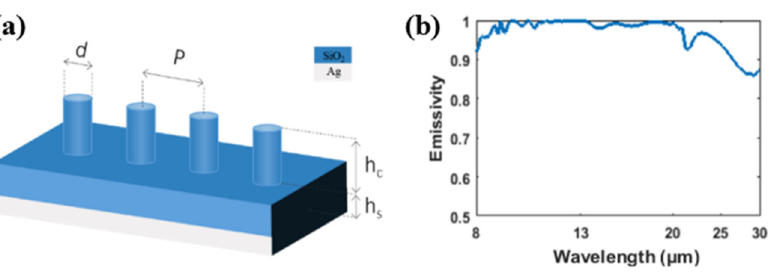
Figure 10. ( a ) Improved structure: patch-antenna-like cylinder array. The period ( P ) of the cylinder is 12 µ m. The diameter ( d ) of the cylinder is 4 µ m. The thickness of the silica layer ( h s ) is 100 µ m. The height ( h c ) of the cylinder is 30 µ m. ( b ) Emissivity of the proposed structure in the atmospheric transparent window.